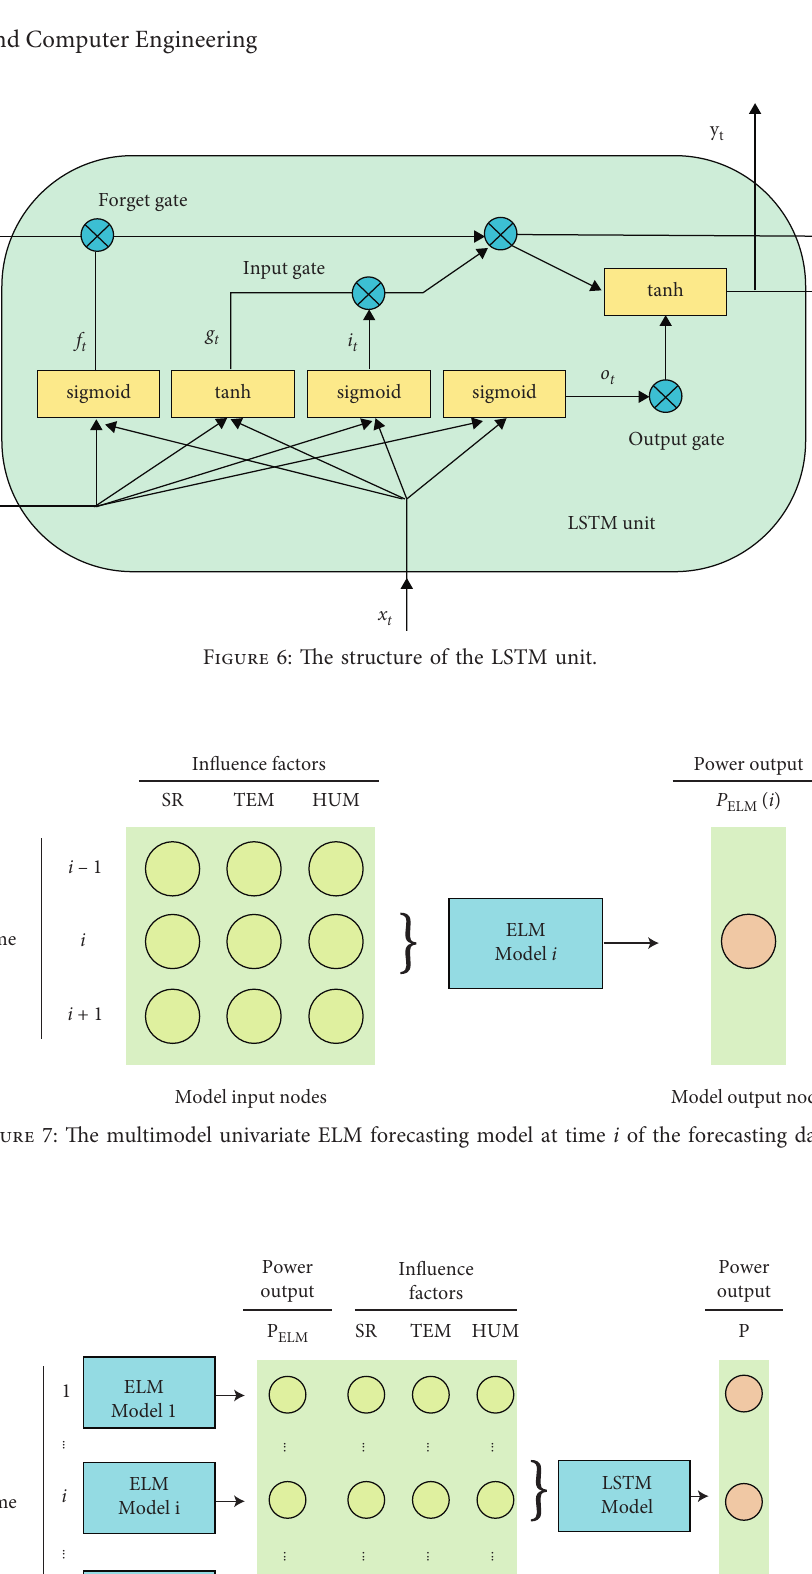
Model output nodesModel input